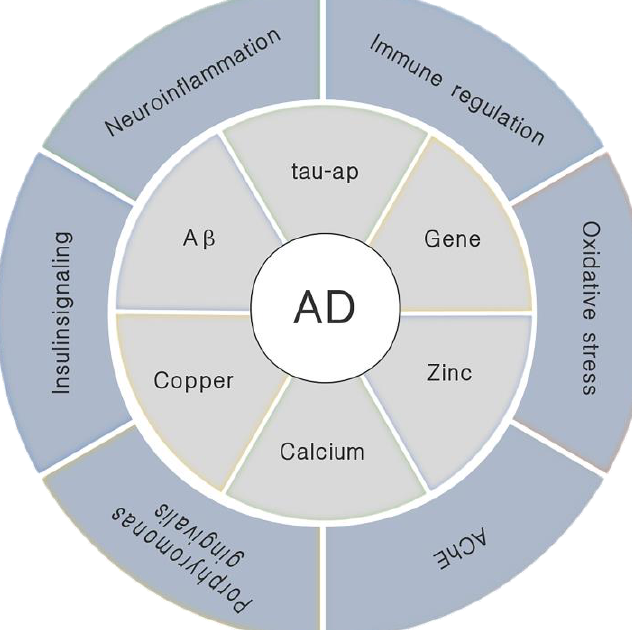
Figure 1. Various pathogenic factors that trigger Alzheimer’s disease (AD).